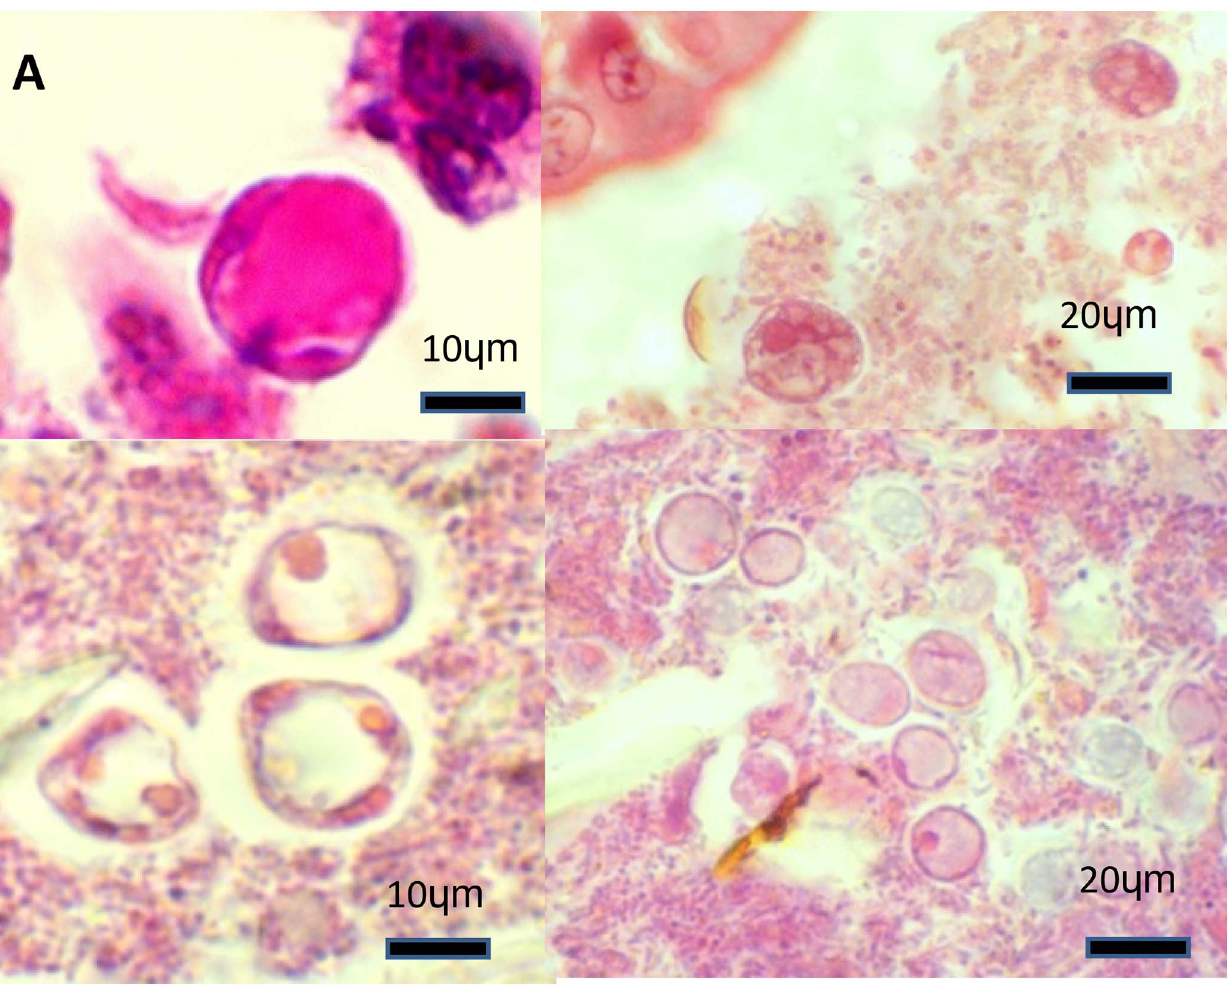
Figure 2. Histological images of Blastocystis organisms in the porcine intestinal biopsies. Haematoxylin and eosin. (A) Caecum from a commercial pig: a Blastocystis vacuolar form amongst intestinal lumen material (100X). (B) Colon from a research pig: several Blastocystis granular forms found near the tip of the intestinal epithelium (40X). (C) Colon from a commercial pig: three Blastocystis vacuolar forms of amongst luminal material (100X) (D) Colon from a commercial pig: several vacuolar Blastocystis organisms scattered amongst intestinal lumen material